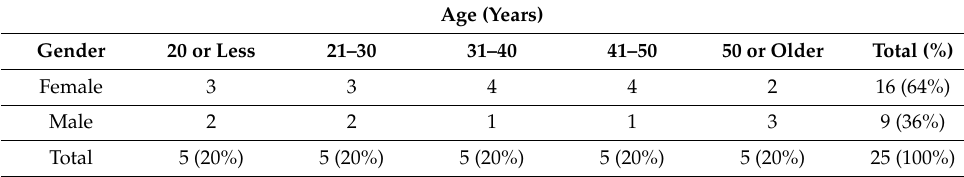
Table 2. Age and gender make-up of consumer panel in the consumer acceptance test.